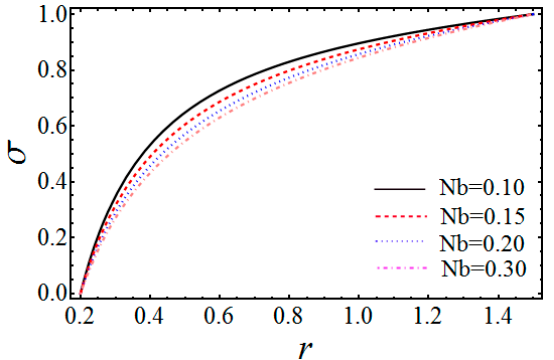
Figure 11. Variation of nanoparticles phenomenon σ with Nb for fixed θ = 0.1, ϕ = 0.5, δ = 0.1, ε = 0.1, z = 0, t = 0.3, Nt = 0.2.